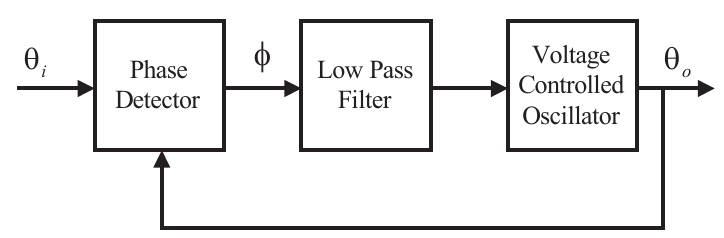
Figure 6. Basic Configuration of a PLL.